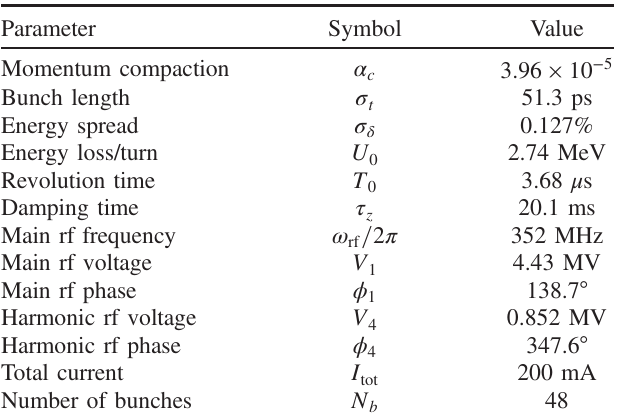
TABLE II. Longitudinal lattice and rf parameters for the APS-U multibunch